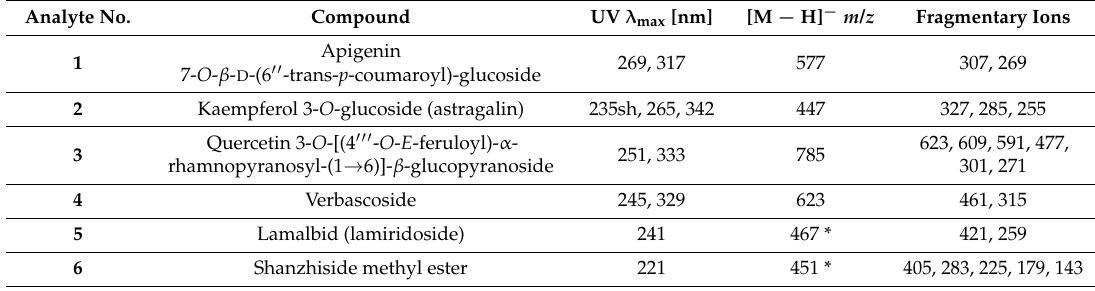
Table 1. The spectral data of compounds isolated from the herb of L. album